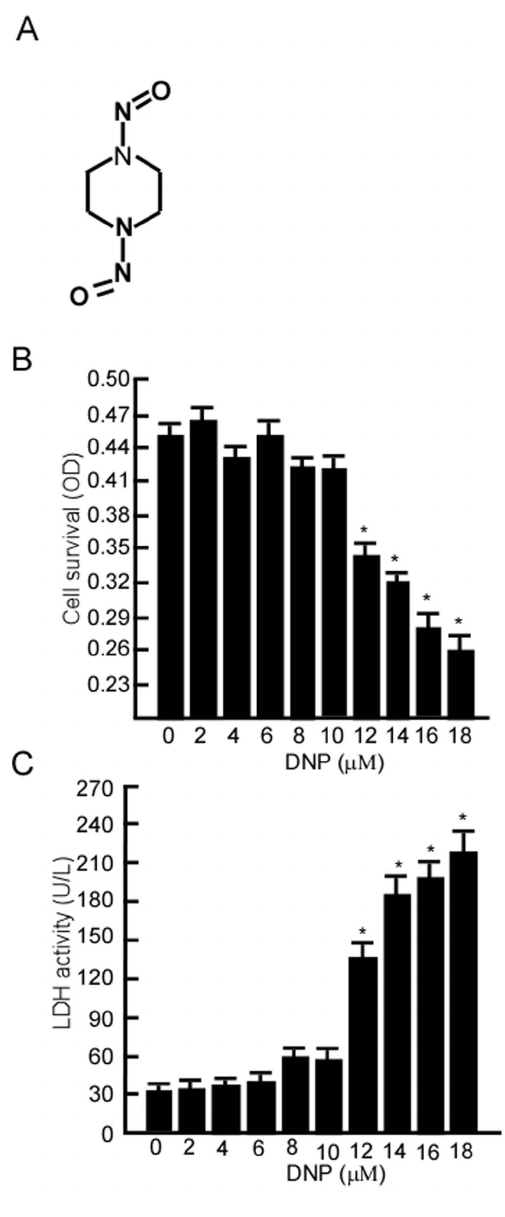
Figure 1. Non-cytotoxic concentration of N , N 9 -dinitrosopiper- azine (DNP) in 6-10B cells. A, Structure of DNP, an N -nitroso compound. B, 6-10B cells were treated with the indicated concentration DNP for 48 h before being subjected to the MTT cell viability assay. C, After 6-10B cells were treated with the indicated DNP concentration for 48 h, cell media were subjected to the LDH assay. The optical density (OD) indicates the relative OD at 563 nm. Lactate dehydrogenase (LDH) activity is expressed per 1 L of media. Data are presented as means 6 SD from 3 independent experiments. Statistical analysis was performed using the Student’s t test (*, p , 0.05). The number of cells in random fields of view were counted under a light microscope and deemed ‘‘invading cells.’’ To determine cell motility, the treated cells were seeded into the Boyden Chamber on membrane filters that were not coated with Matrigel. Migration of cells was measured as described in the motility assay [40]. Statistical analysis was corrected with cell viability to clarify normalize the effects of DNP treatment.